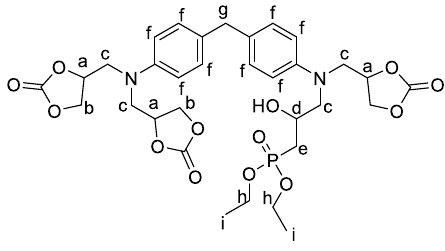
Figure 13. MBDAC-DEP structure.